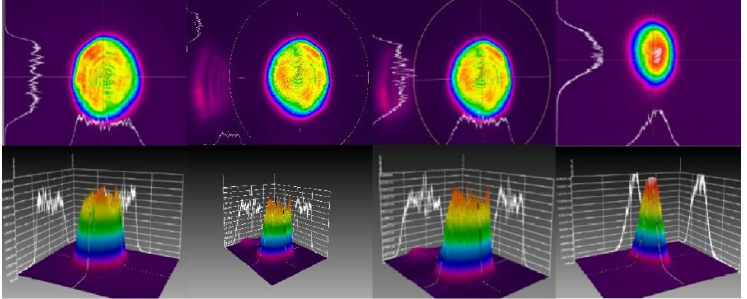
Figure 4. Energy distribution of laser at 266 nm, 355 nm, 532 nm and 1064 nm wavelength in 2D/3D.